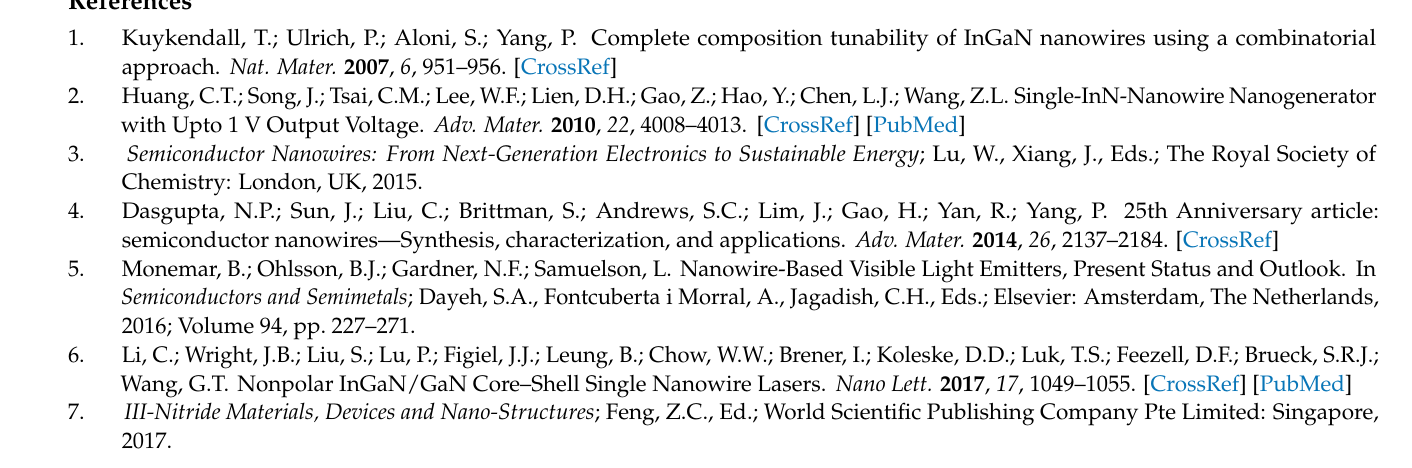
10¯10 GaN Bragg peak of two free-lying GaN NWs with diameters of 200 nm. (c,d) A different view of these Bragg peaks from a direction perpendicular to the [0001] crystallographic axis. The Bragg peaks demonstrate the “double-star” structure typical for the bent GaN NWs. Figure S3: SEM images of the contacted GaN NWs. The first 350 nm GaN NW before (a) and after (b) applied voltage bias. The second 350 nm GaN NW before (c) and after (b) the maximum applied voltage. The 200 nm GaN NW before (e) and after (f) the applied voltage bias. Figure S4: SEM images of the second type of Au contacts. The NW with the diameter of 200 nm contacted on the top of the Au electrodes by melting procedure before (a) and after (b) applied 0.1 V of bias. (c) The 350 nm GaN NW on the top of Au contacts. Figure S5: Evolution of the intensity distribution around 10¯10 GaN Bragg reflection of the second contacted GaN NW with the diameter of 350 nm. The values of the applied voltage bias: 0 V (a), 1 V (b), 2 V (c), 5 V (d). Figure S6: Dependence of the scattering vector modulus ( H 10¯10 ) on the applied voltage bias for the first (a) and second (b) 350 nm GaN NW. Similar dependence of the scattering vector modulus ( H 10¯10 ) on the applied voltage bias for the first (c) and second (d) 200 nm GaN NW. Figure S7: Dependence of the bending angle for the first (a) and second (b) GaN NW with the diameter of 200 nm on the applied voltage bias. Figure S8: SEM images of the Pt contacted 200 nm GaN NWs. Figure S9: (a) SEM images of the Pt contacted GaN NW with diameter of 200 nm. (b) Comparison of the diffracted intensity of the 10¯10 GaN Bragg reflection of the NW before (up) and after (bottom) deposition of the Pt contacts. (c) 3D intensity distribution around 10¯10 GaN Bragg reflection of the